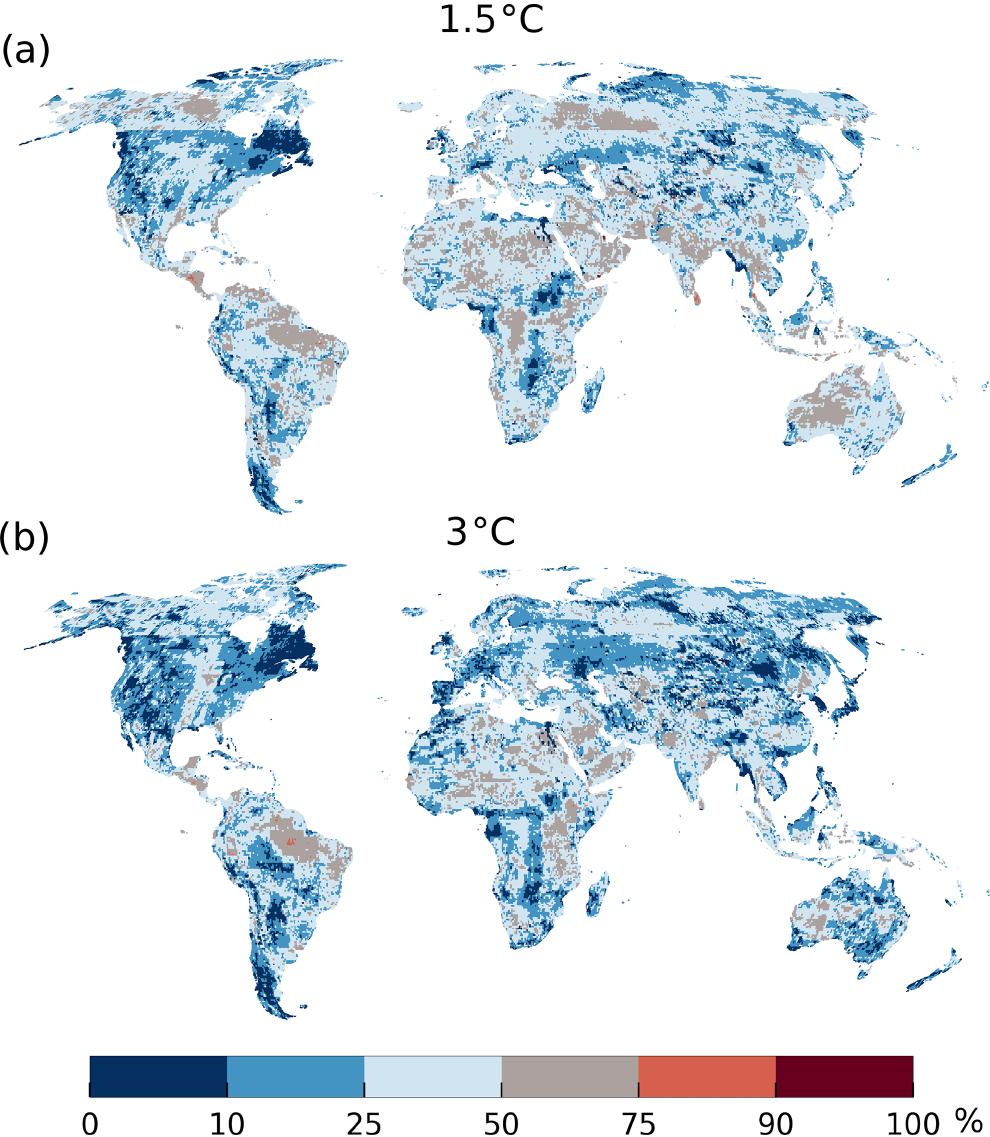
Figure 5. GCM variance in percent of the total variance of GWR change from eight GHMs and four GCMs at 1.5 ◦ C (a) and a 3 ◦ C (b) GW (see also Sect. 2.4). Red depicts areas where the GCMs are responsible for the majority of the variance in GWR change. Blue areas indicate where the main variance is introduced through